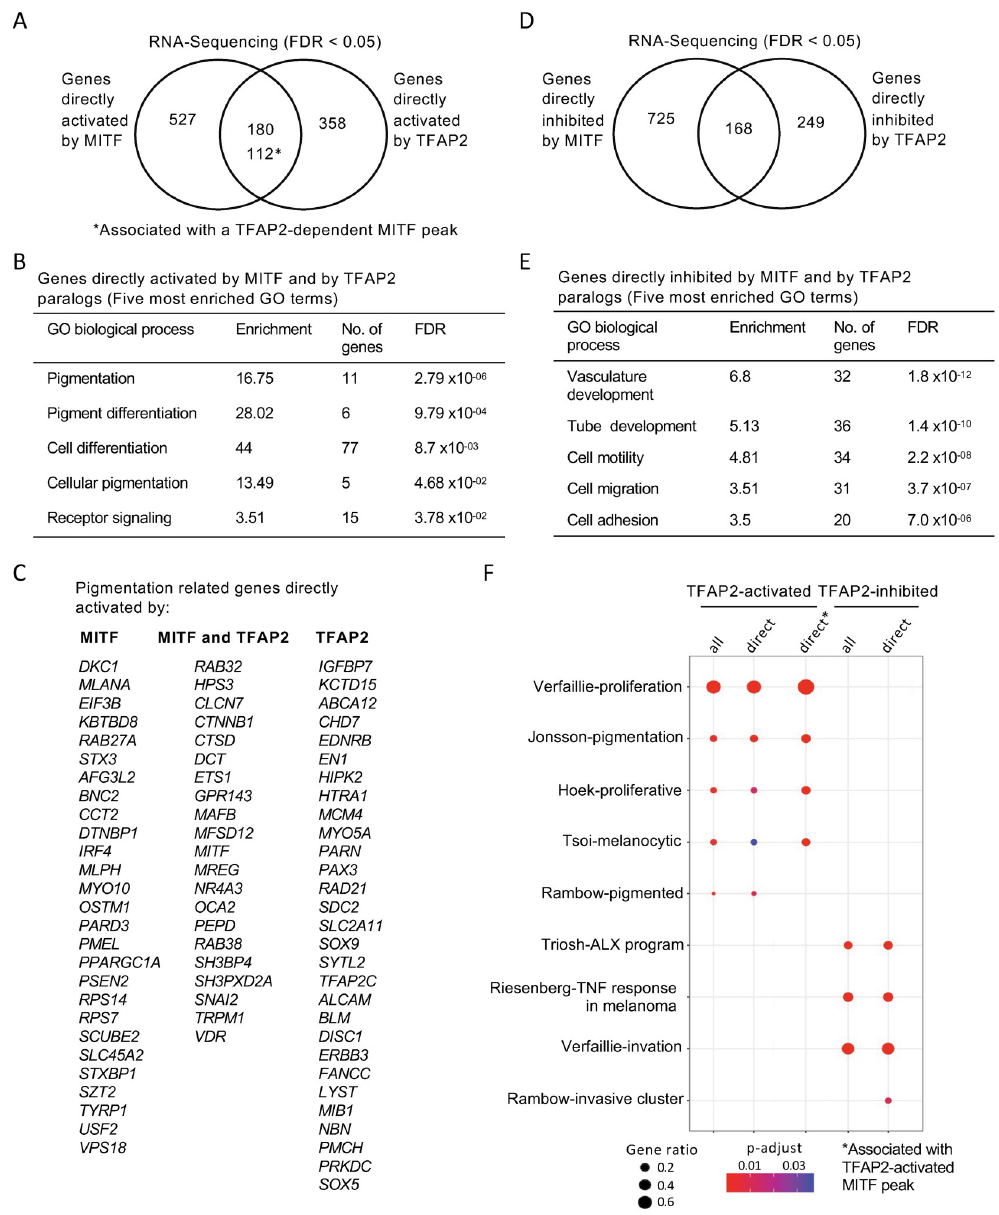
Fig 5. TFAP2 and MITF co-regulate pigmentation and cell differentiation genes in SK-MEL-28 cell lines. ( A ) Venn diagram representing the overlap of genes apparently directly activated by MITF (i.e., expression lower in MITF -KO than in WT cells, FDR < 0.05, and an MITF peak within 100kb of the TSS) and genes directly activated by TFAP2 (i.e., expression lower in TFAP2 -KO than in WT cells, FDR < 0.05, and an TFAP2-activated enhancer of any category within 100kb of the TSS). The number of overlapping genes with TFAP2-dependent MITF peaks are also shown ( � ). ( B ) Gene ontology (GO) biological process analysis enriched among MITF- and TFAP2-activated genes are shown (Top 5 hits). ( C ) A curated list of pigment-associated genes [118] was intersected with directly MITF-activated genes, overlapping genes of directly MITF- and TFAP2-activated genes, and directly TFAP2-acitvated genes and represented by gene list. ( D ) Venn diagram representing directly MITF inhibited genes (MITF peak within 100kb of a TSS), based on RNA-seq, in MITF -KO versus WT cells (FDR < 0.05) and directly TFAP2 inhibited genes (TFAP2-inhibited enhancers, of any category, within 100kb of a TSS), based on RNA-seq, in TFAP2 -KO versus WT cells (FDR < 0.05). ( E ) Gene ontology (GO) biological process analysis enriched among MITF- and TFAP2-inhibited genes are shown (Top 5 most enriched GO terms). GO analysis was performed using PANTHER. ( F ) Dot plot of enrichment analysis showing the enrichment of melanoma gene signatures from the literature in directly TFAP2-activated and TFAP2-inhibted genes. P value is red lowest to blue highest; gene ratio is the fraction of all genes in the gene signature category that are included in the set identified here. TFAP2-activated genes associated with TFAP2-dependent MITF peaks are shown ( �